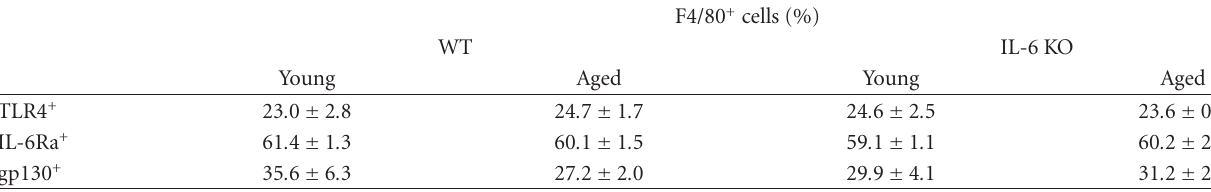
Table 2: Percentage of TLR 4 + , IL -6 Ra + , and Gp 130 + in F 4 / 80 +